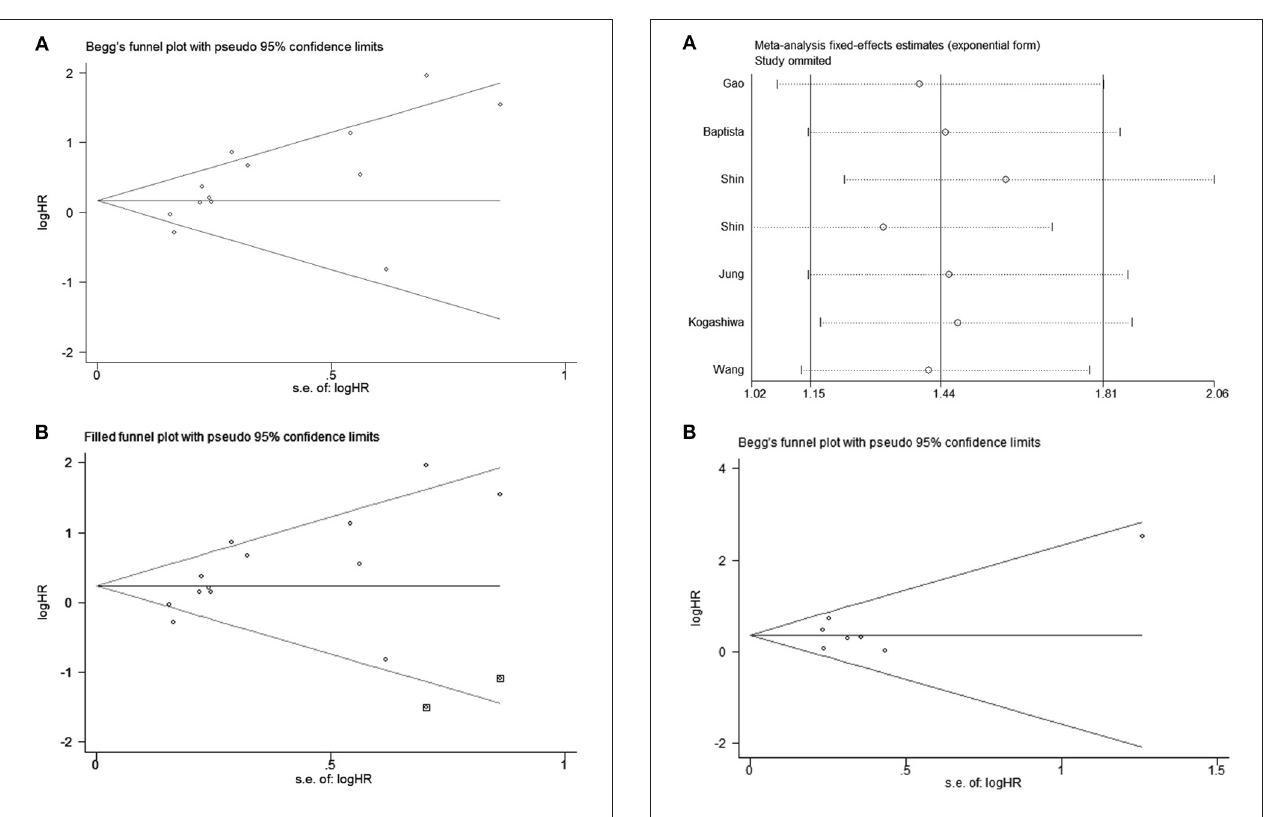
FIGURE 6 | (A) Sensitivity analysis of the effect of individual studies on the pooled HRs for PD-L2 and DFS/PFS; (B) Funnel plots for publication bias of PD-L2 on